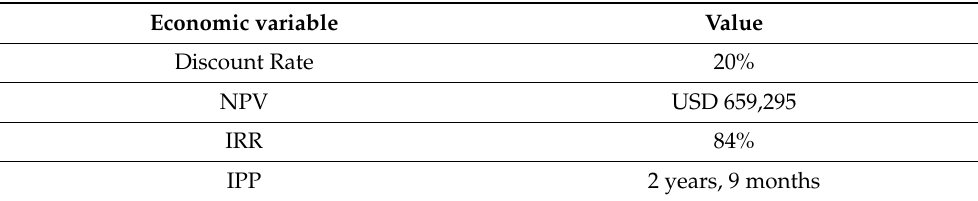
Table 18. Economic variables in the TMS implementation.